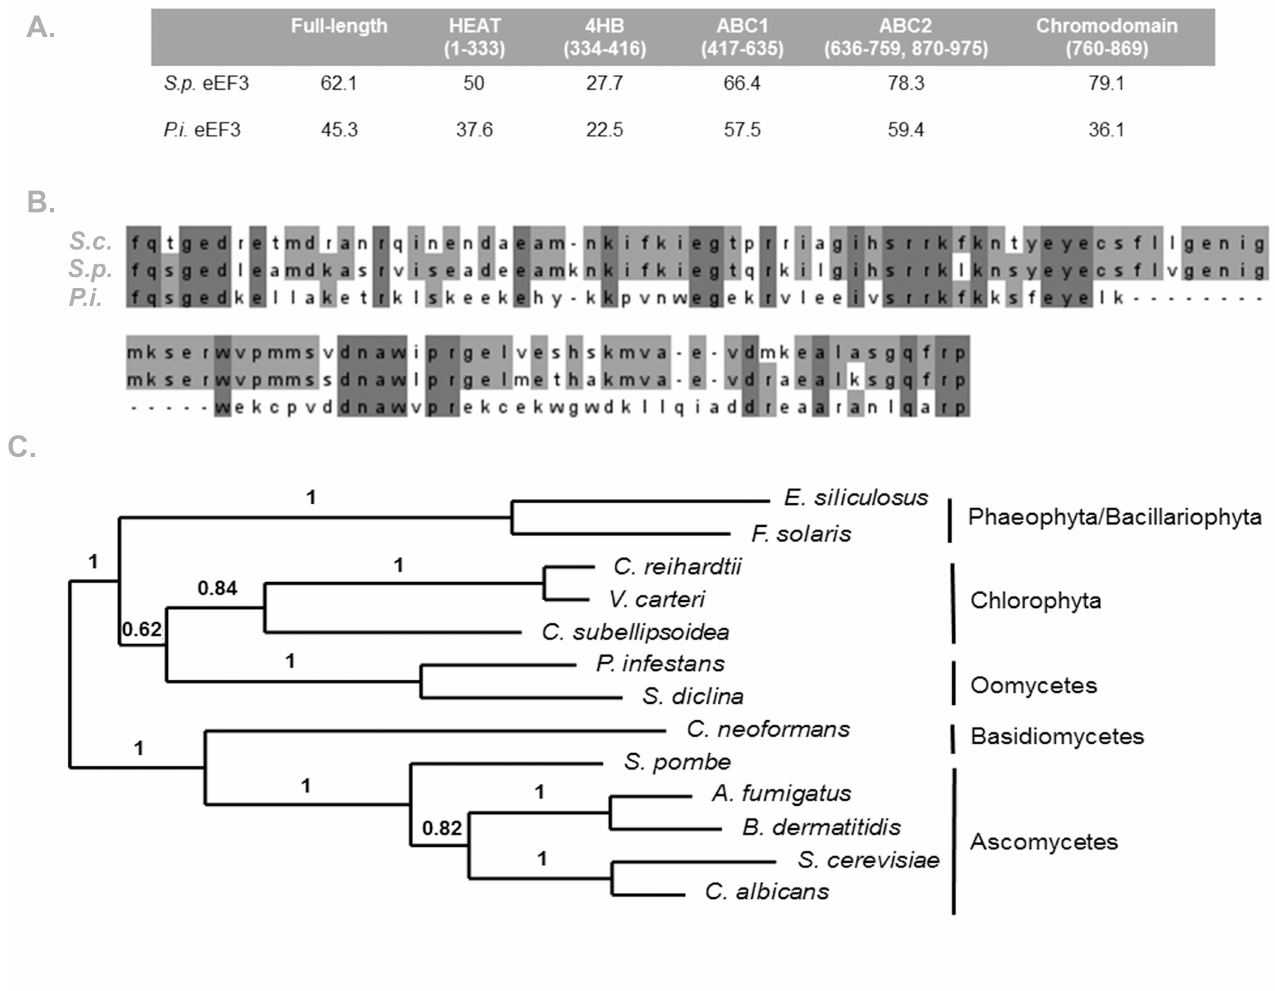
Fig 5. Domain specific differences in the conservation of eEF3. (A) Individualdomainsof S . cerevisiae (S . c . ) , S . pombe(S . p . ) , and P . infestans (P . i . ) eEF3 were alignedusing Clustal Omega and the percentage identity to S . cerevisiae eEF3 is shown [23, 24]. The amino acids comprising each domain in S . cerevisiae are indicated. (B) Alignment of the chromodomain of S . cerevisiae , S . pombe ,and P . infestans eEF3 was performed using Clustal Omega and shadingbased on identity was done using Jalview[25]. Dark gray represents identity in all three speciesand light gray represents identity in two species. (C) Maximum likelihoodtree with 500 bootstrapreplicates created using phylogeny.fr.